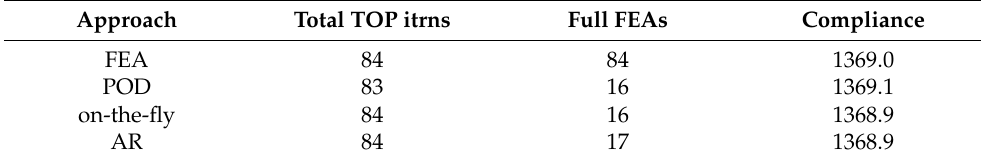
Table 3. Cantilever Beam 2: Results of each MOR approach as well as the classic implementation.